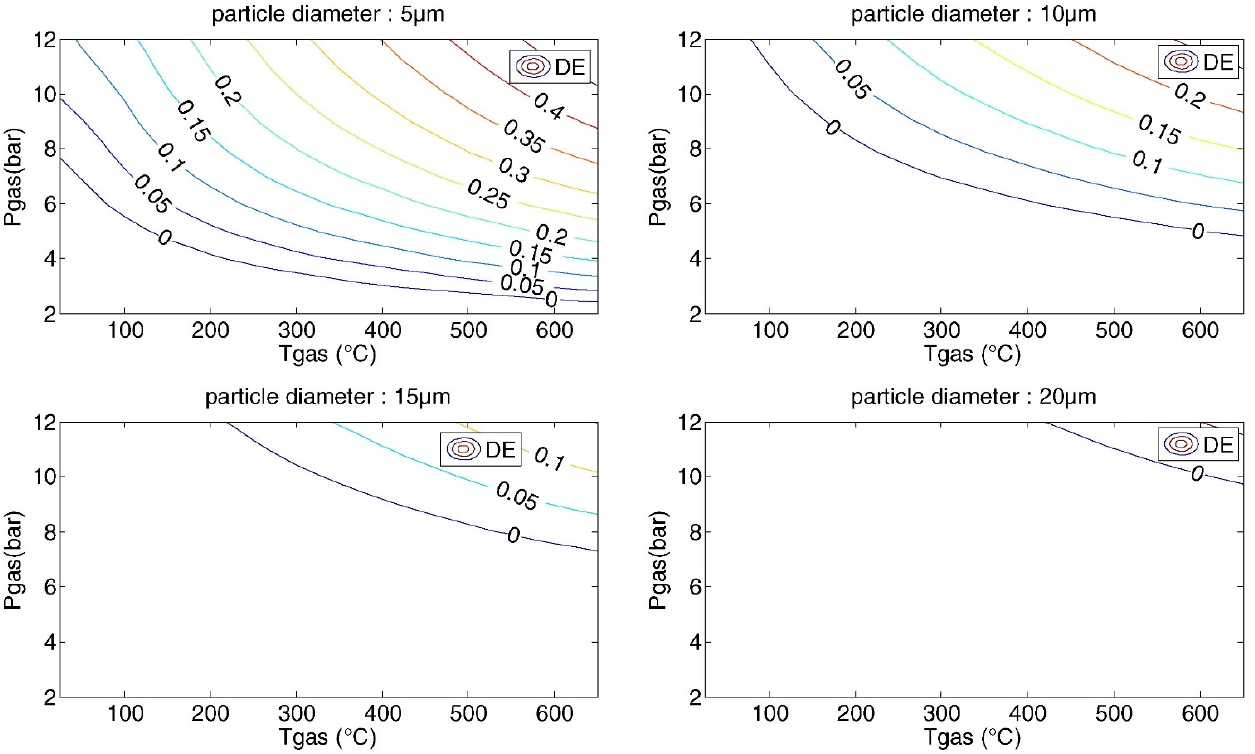
Figure 2. Computed DE for an air pressure range of 2–12 bar, a gas temperature range of 20–630 °C, and a particle diameter of 5, 10, 15 and 20 µm . Reprinted/Adapted with permission from [69]. Copyright 2016 Elsevier.